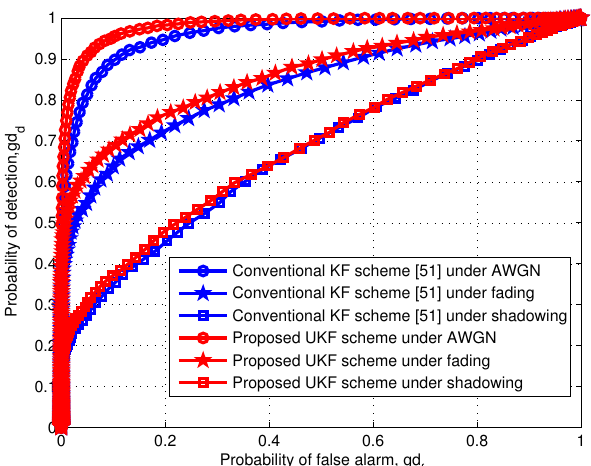
Figure 12. Detection gain comparison between Kalman filter (KL) and unscented Kalman filter (UKF) under different fading